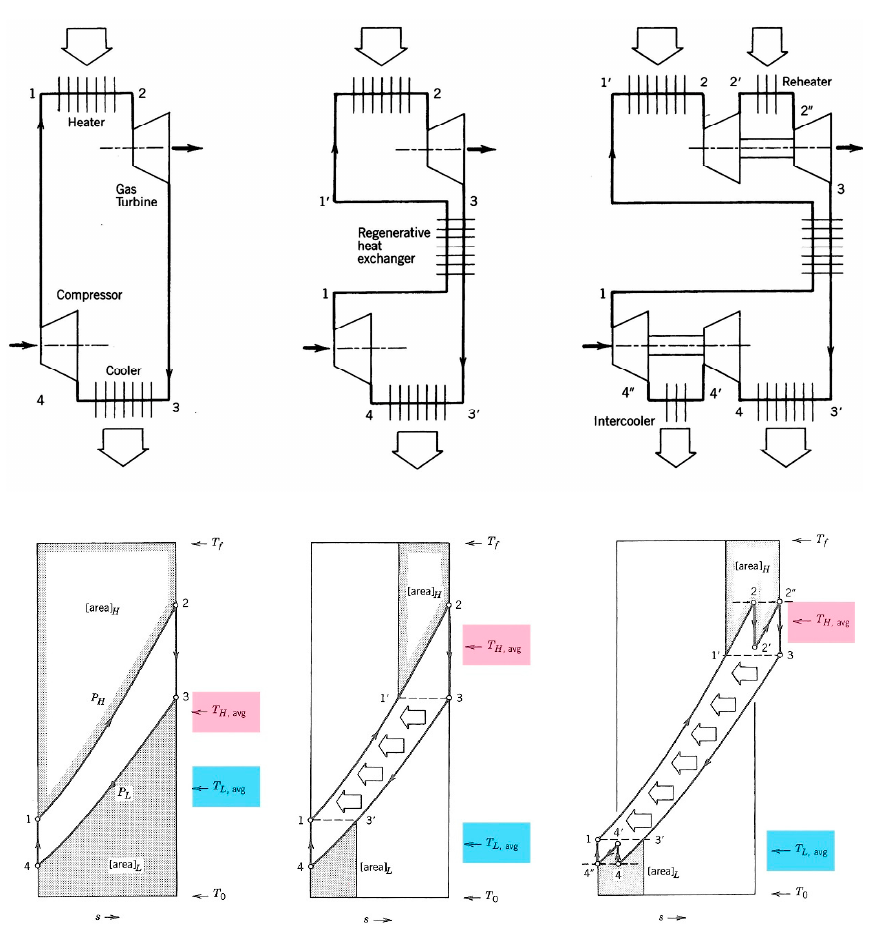
Figure 6. The evolution of the configuration of gas-turbine power plants [21].